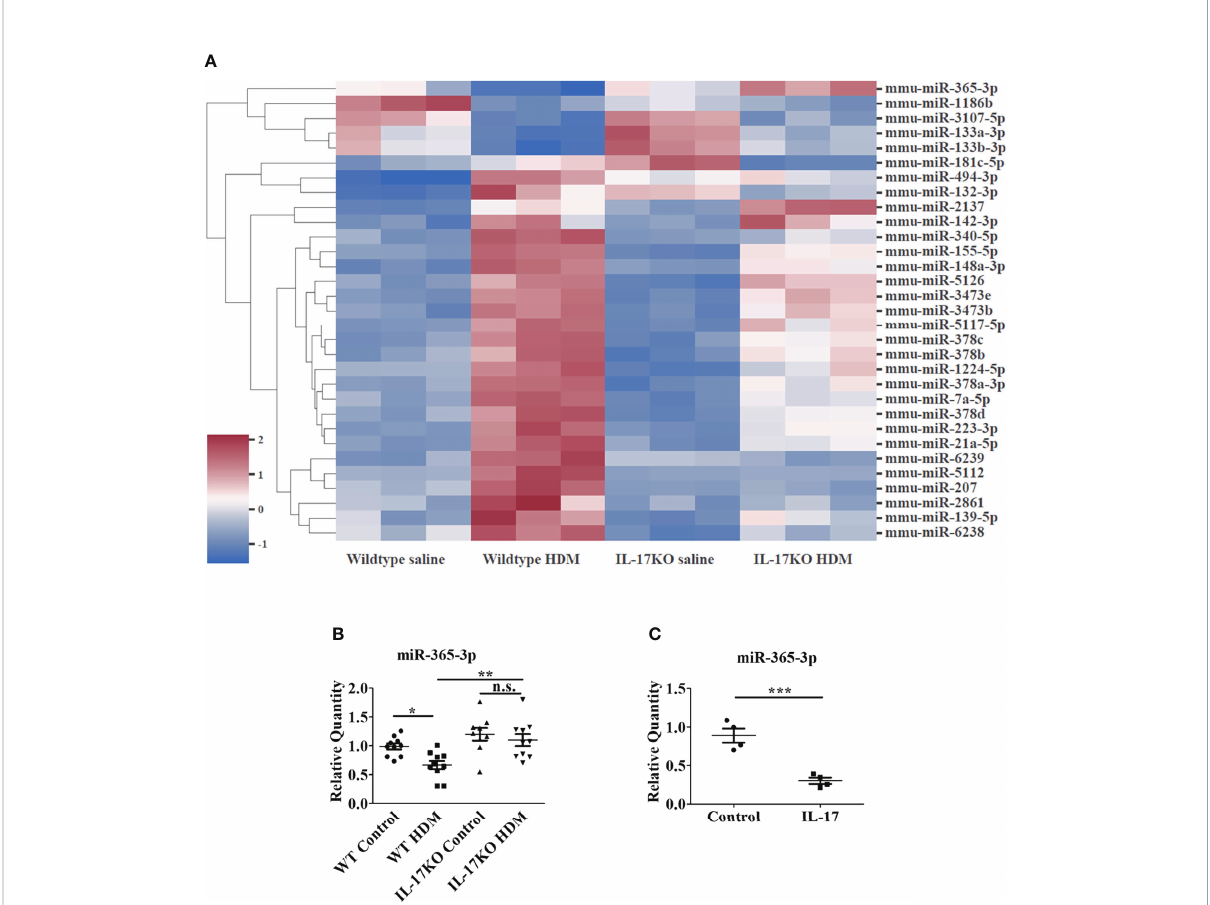
FIGURE 3 miR-365-3p is downregulated in wildtype HDM-induced mice but not in IL-17 KO HDM-induced mice. (A) Microarray of dysregulated miRNA in wildtype saline and HDM-induced mice, N=3. (B) The level of miR-365-3p examined by qRT-PCR in wild-type and IL-17KO mice. N=10. (C) The effect of IL-17 in miR-365-3p expression in MLE-12 cells. The MLE-12 cells were treated by IL-17, and the miR-365-3p expression was tested by qRT-PCR N=4. *, P<0.05, **, P<0.01, ***, P<0.001. n.s., not statistically signi fi cant.